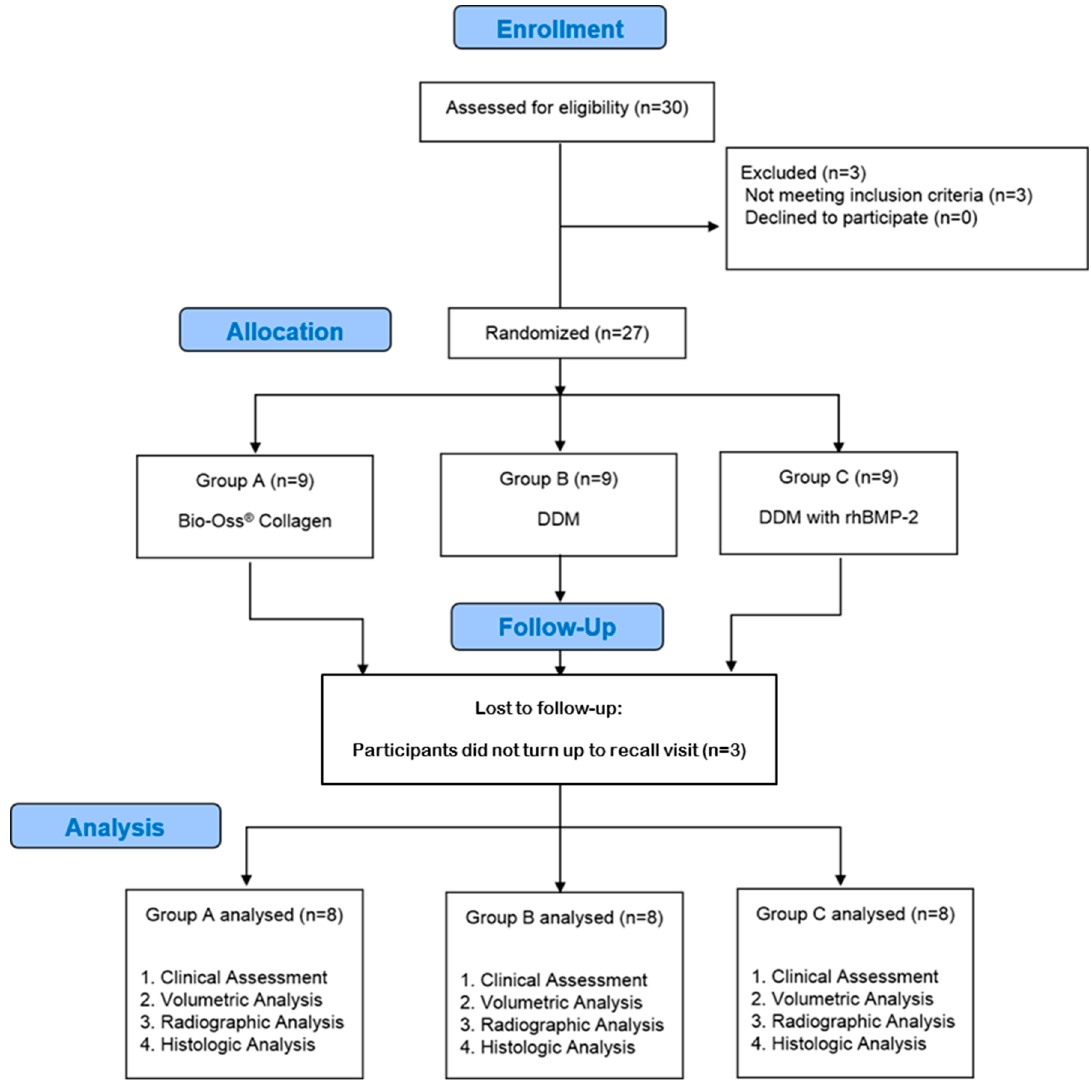
Figure 1. Study flowchart showing the participants enrolled in this study.